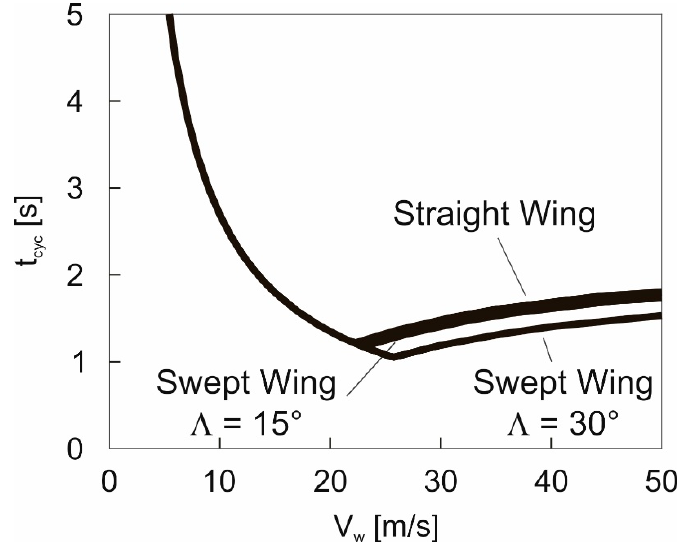
Figure 17. Effect of wing sweep on the cycle time for swept wing configuration 1 in maximum-speed dynamic soaring.